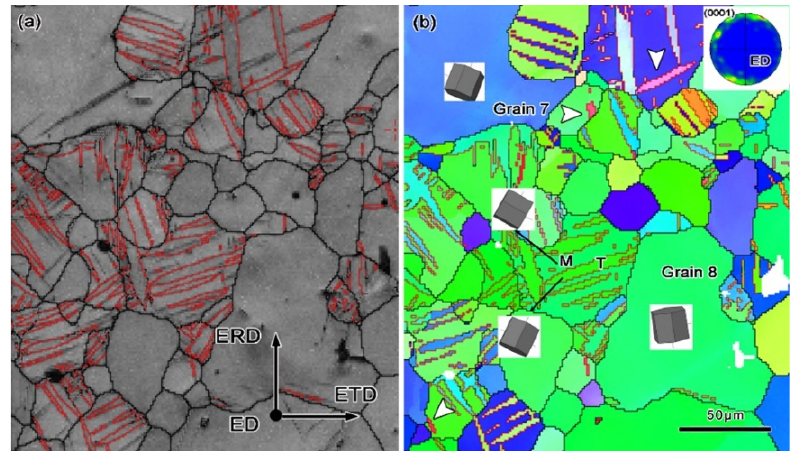
Figure 6. Typical EBSD results of the 1.3% pre-strained and annealed samples under tension along ED to a strain ~1.2% (ERD1.3CA-ED1.2T) in band contrast ( a ) and in inverse pole figure map ( b ). The boundaries of {10 12} twins are colored in red. The corresponding pole figure of the areas shown in Figure 5b is inserted at the right upper corner.